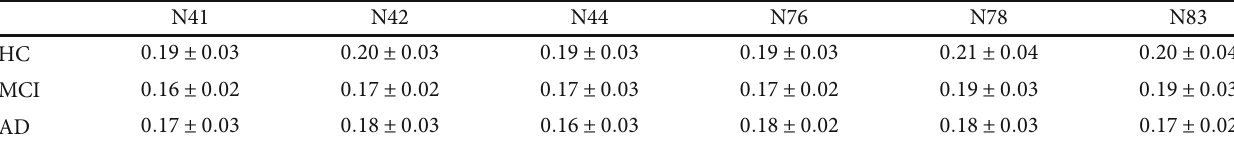
Figure 4: Box plots of ANCOVA analyses on clustering coe ffi cient. Signi fi cant di ff erences across HC, MCI, and AD stages were found in 6 brain parcels of rs-FC networks constructed with (a) Pearson correlation, in 3 brain parcels of rs-FC networks constructed with (b) DTW, and in 52 brain parcels of (c) GIG-ICA dominant component networks. For simpli fi cation, only 6 nodes were displayed in (c). Table 4: Clustering coe ffi cient ( mean ± standard ) of the nodes that can signi fi cantly di ff erentiate HC, MCI, and AD groups. The edge weights were estimated with Pearson correlation.